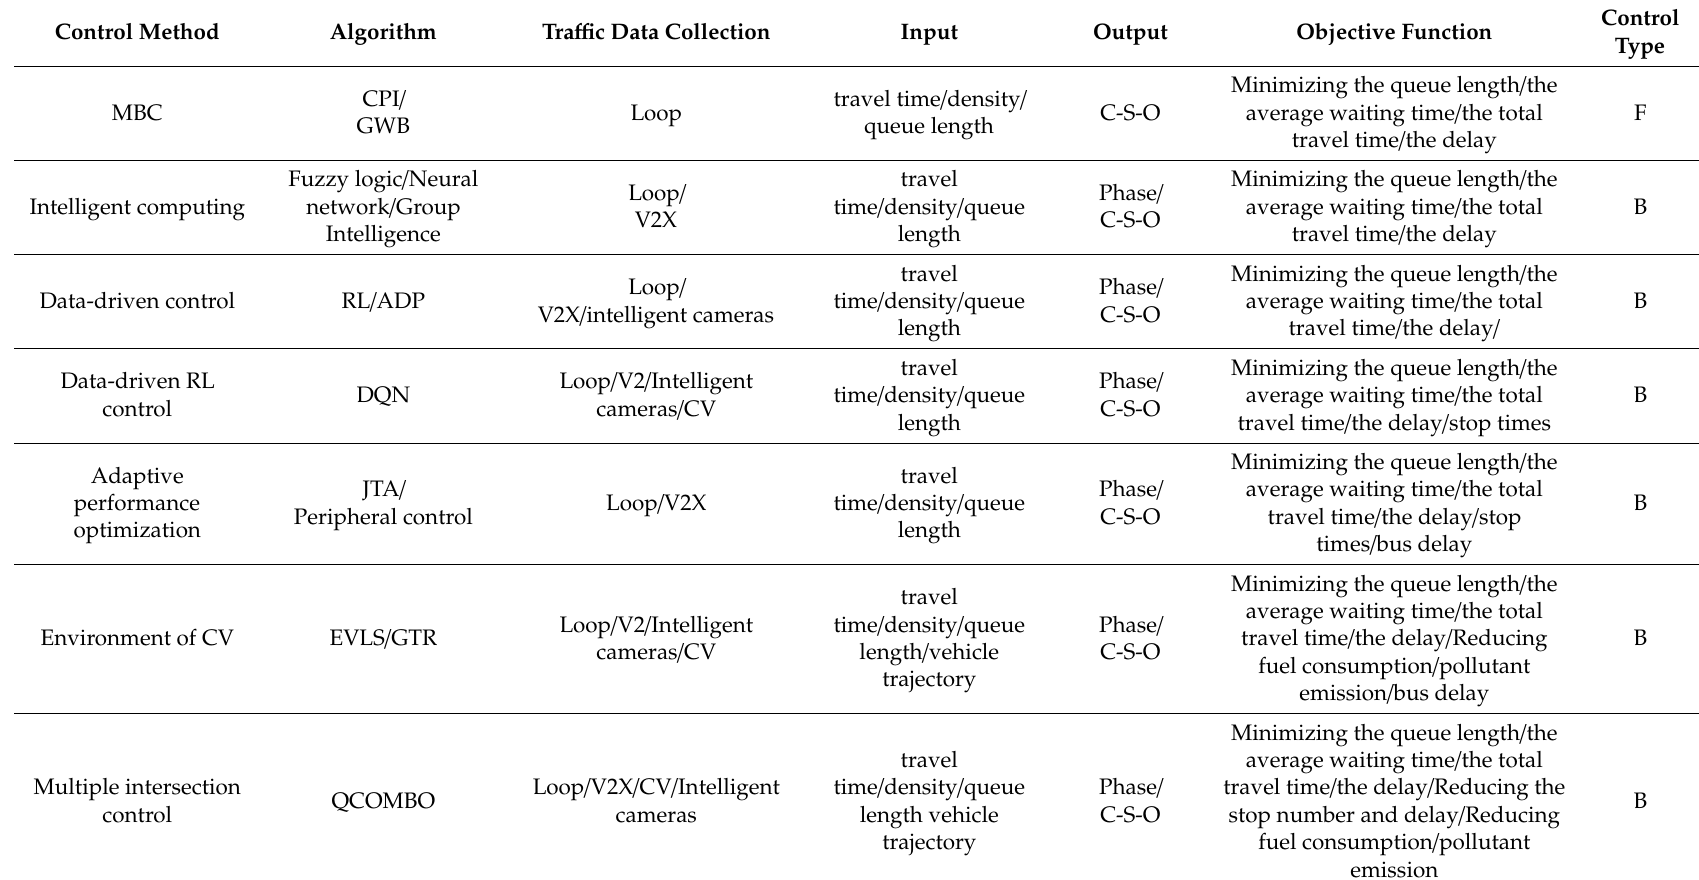
Table 2. Main technical features of multiple adaptive control